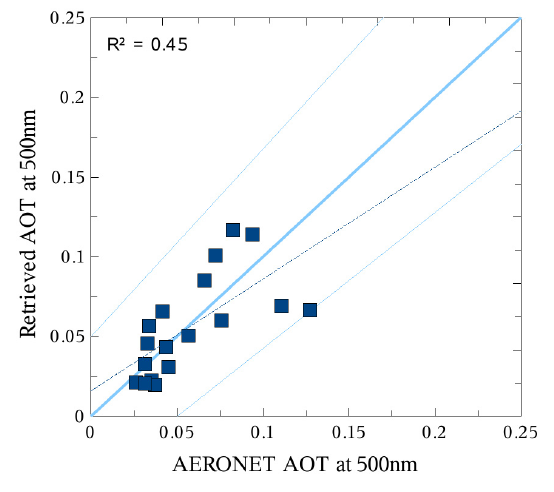
Fig. 10. Comparison of the retrieved AOTs derived from AATSR product as 3.7µm and AERONET AOTS for station PEARL. The dashed line represents the linear regression of the data. RMSD=0.0329, R 2 =0.42.